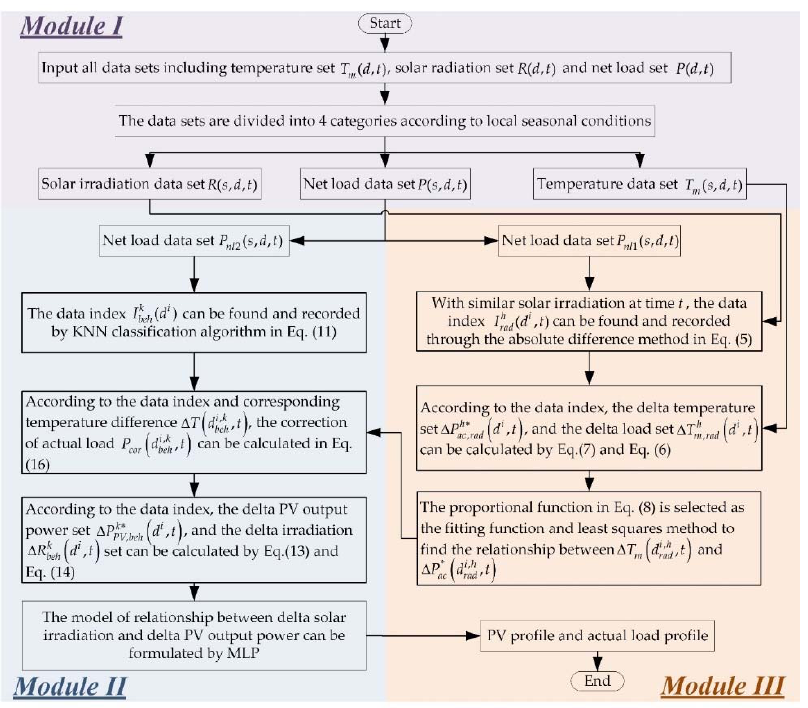
Figure 3. Flowchart of photovoltaic (PV) output power decomposition.